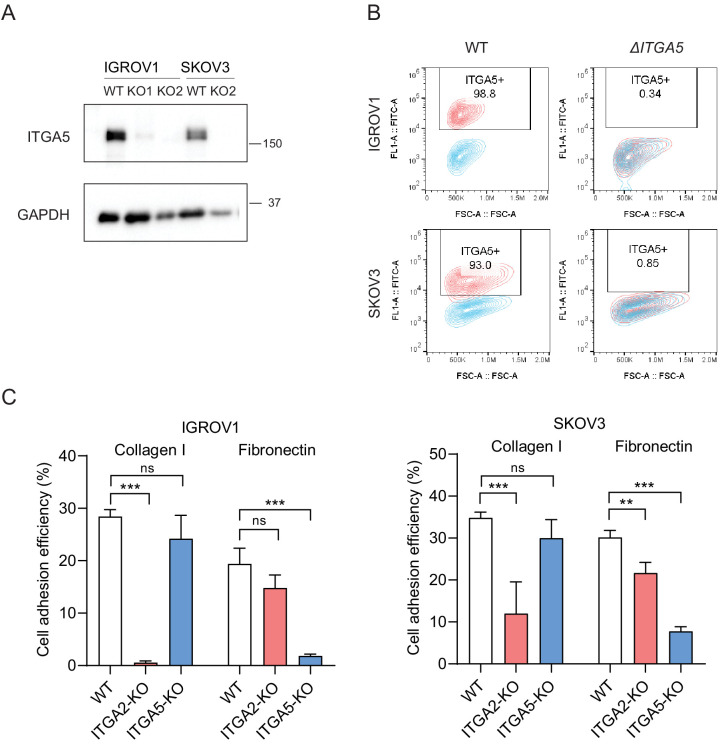
Establishment and characterization of ITGA5 knockout ovarian cancer cell lines.(A) Immunoblot confirmed loss of ITGA5 expression in IGROV1 and SKOV3 ΔITGA5 (KO) cell lines. (B) Representative flow cytometry analysis of ΔITGA5 cells stained with primary anti-human ITGA5 antibody and goat anti-mouse-FITC secondary antibody. (C) Cell-ECM adhesion assay of WT, ΔITGA2, and ΔITGA5 cancer cells. Bar chart summarizes percentage of cell-ECM adhesion efficiency from two independent experiments (***p<0.001, unpaired Student’s t-test).